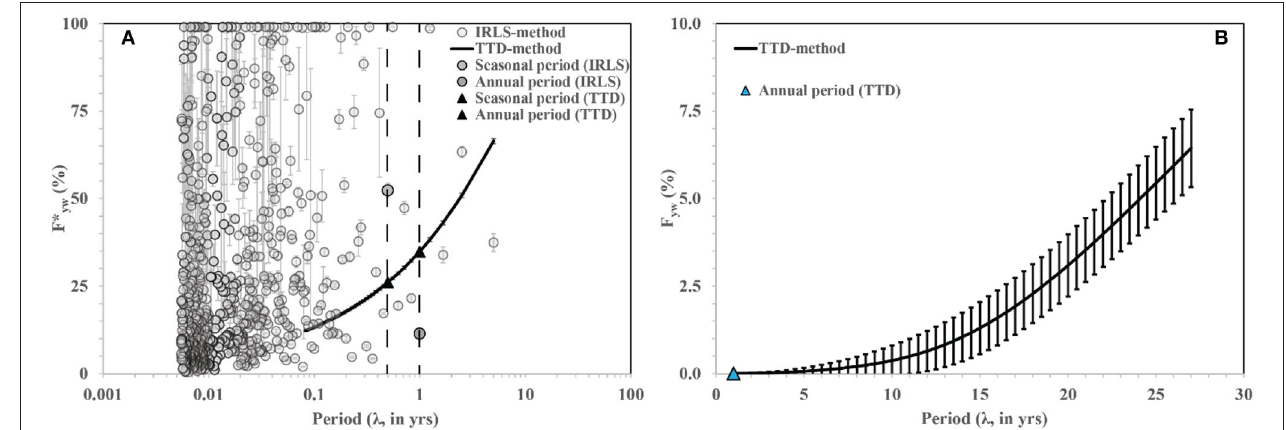
FIGURE 6 | (A) F * yw (ensemble mean ± one standard deviation) vs. period ( λ ) based on δ 18 O data and (B) F yw (ensemble mean ± one standard deviation) vs. period ( λ ) based on 3 H data. The vertical error bars in each plot denote one standard deviation. The two gray points in (A) show ensemble mean F * yw estimates for seasonal (0.5 years) and annual periods using the IRLS method; the two black triangles show ensemble mean F * yw estimates for seasonal and annual periods using the TTD method. The two vertical dashed lines in (A) mark the seasonal and annual periods. The blue triangle in (B) shows the ensemble mean of F yw for the annual period, calculated using the TTD method and 3 H